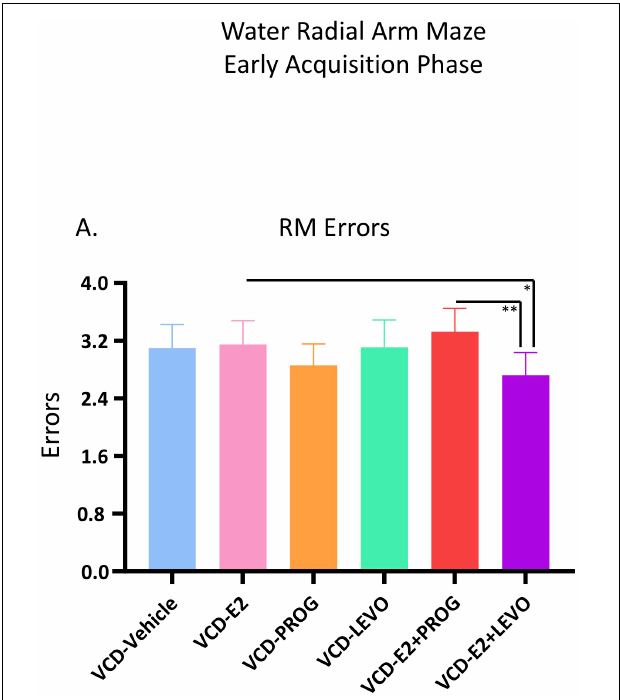
FIGURE 3 | Early Acquisition Phase RM Errors Across All Trials (Two-Group Comparisons). The VCD-E2 + LEVO group showed enhanced reference memory performance compared to the VCD-E2 group ( p < 0.05) and compared to the VCD-E2 + PROG group ( p < 0.01) during the Early Acquisition Phase. Significance: ∗ = p < 0.05, ∗∗ = p <